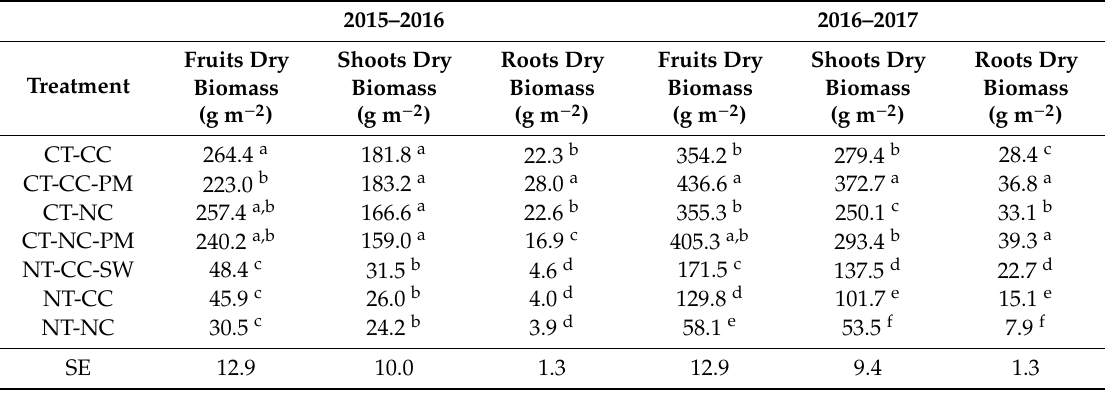
Table 2. Plant dry biomass as a ff ected by tillage and cover crop